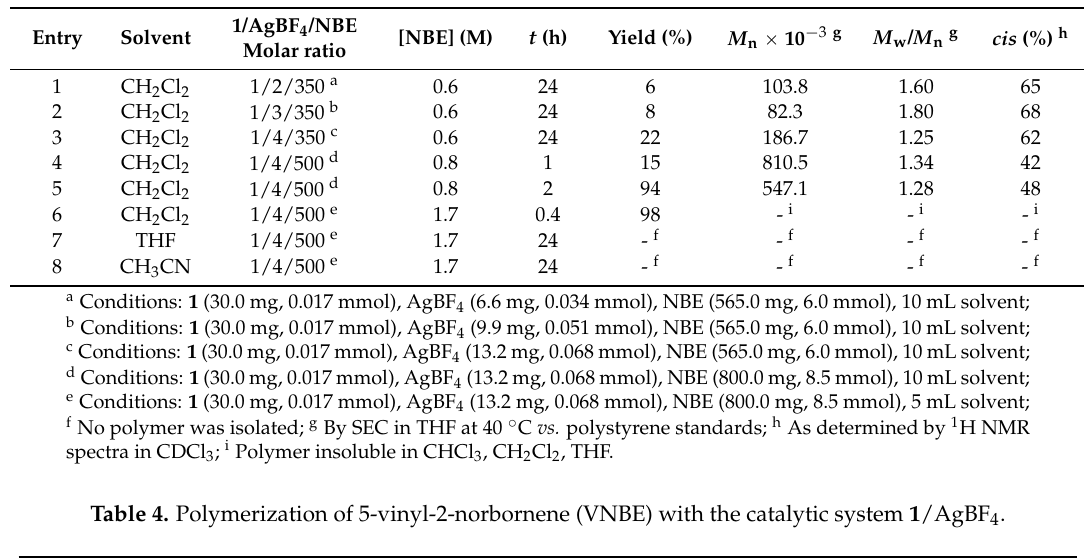
Table 3. Polymerization of norbornene (NBE) with the catalytic system 1 /AgBF 4 .